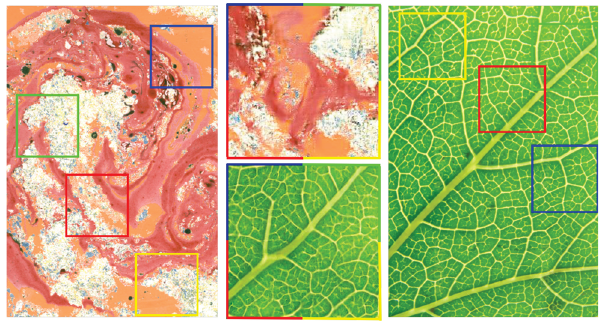
Fig. 1 Given a texture exemplar (left and right), co-occurrence statistics are collected for different texture crops. Using these co- occurrences, our method can synthesize a variety of novel textures with desired local properties (center), similar to those of the corresponding crops from the texture exemplar. Above we demonstrate textures synthesized from co-occurrence statistics collected at four random crops (marked in unique